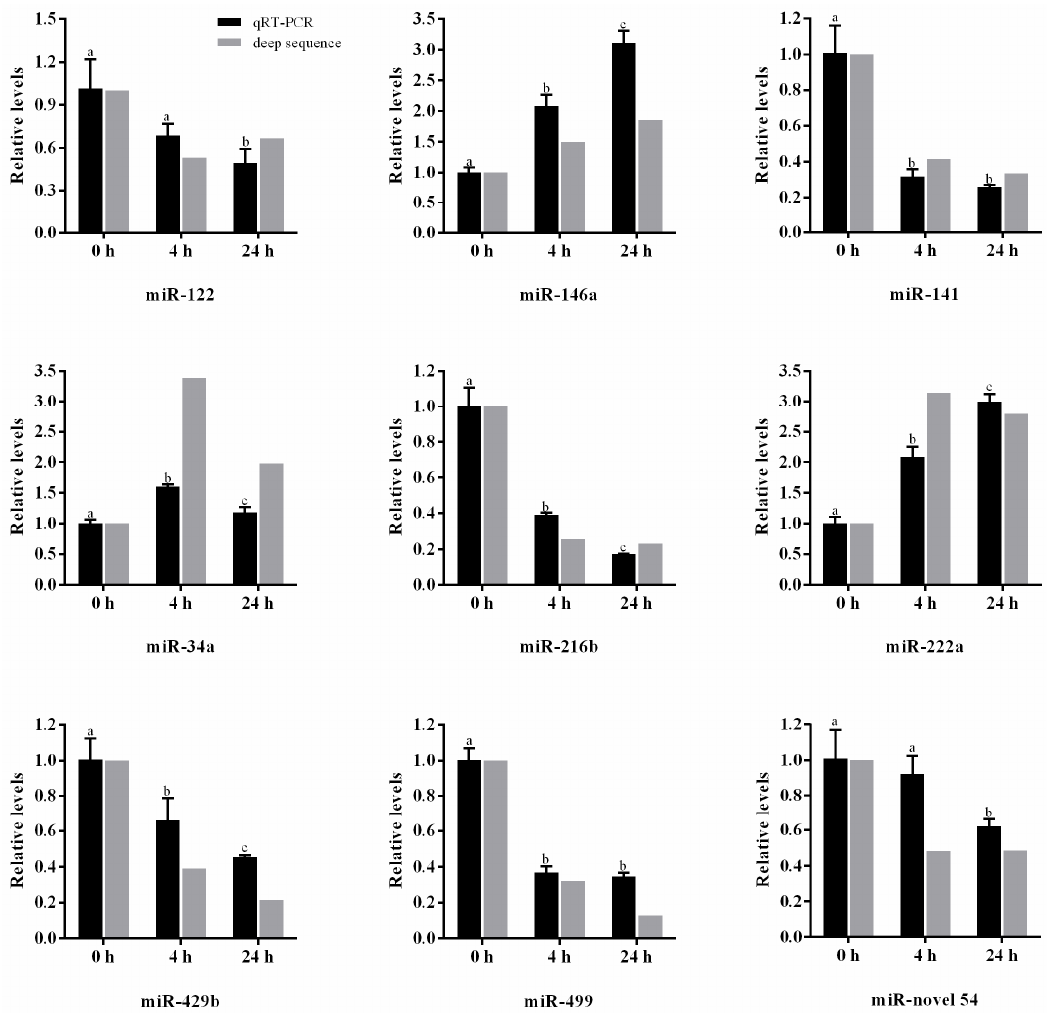
Figure 6. Relative expression levels of nine selected miRNAs in the three libraries according to qRT-PCR and high-throughput sequencing. The expression levels of miRNAs in the 0 h library were set to 1. Values were described as mean ± SD ( n = 3 pools, with 7 fish per pool). Differences were determined by one-way analysis of variance (ANOVA). Different letters above pillars indicated statistical significance at the level of p < 0.05.